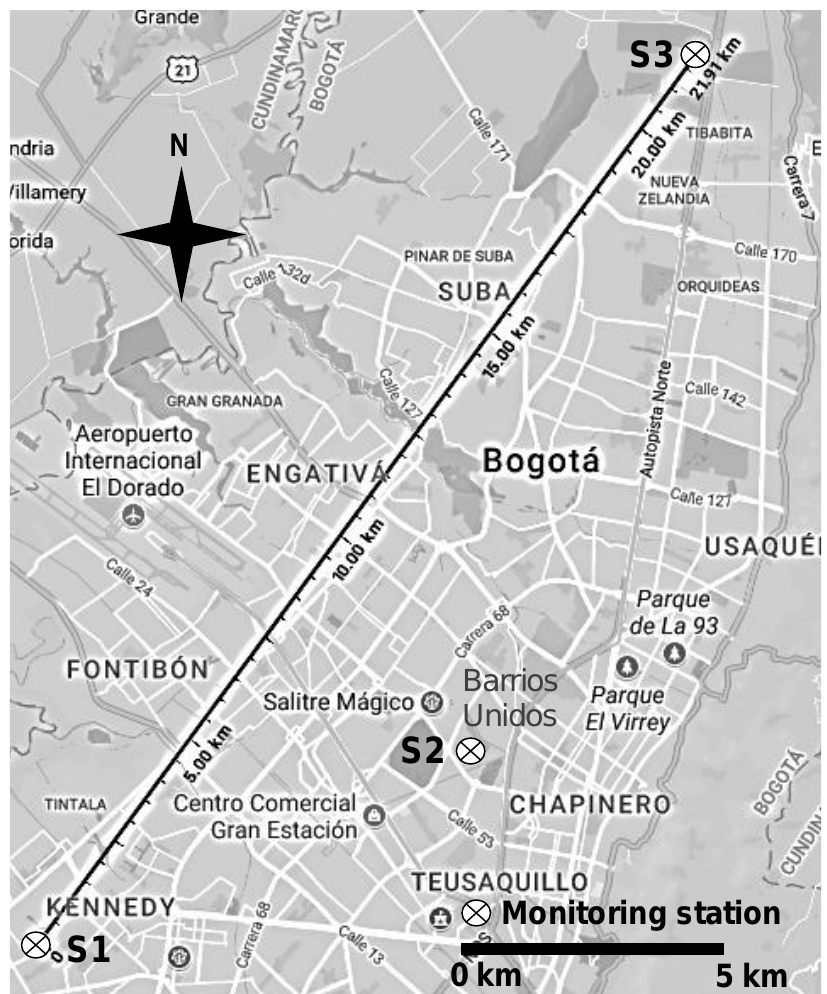
Figure 1. Location of monitoring stations in Bogota, Colombia (Google Maps, 2020). S1 = Kennedy, S2 = Barrios Unidos, and S3 = Suba.